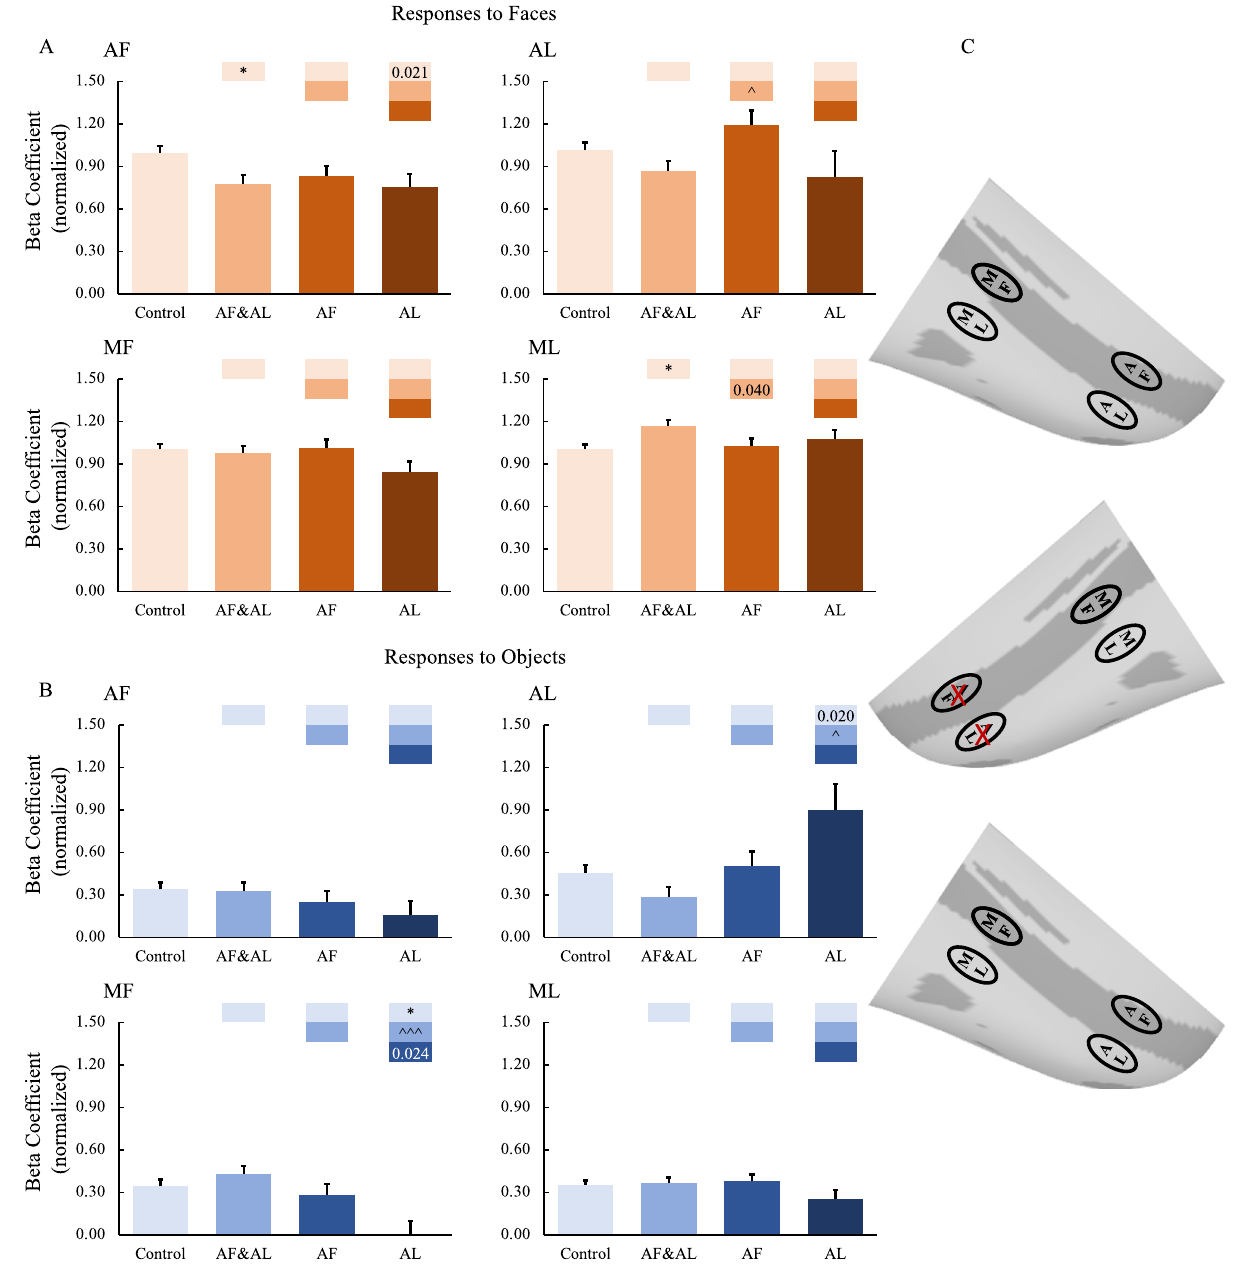
Fig. 6 | Effects of anterior face patch inactivation on responses in the con- tralateral temporal face patches. A , B Effects of anterior face patch inactivation on responses to faces and objects in the temporal face patches in the hemisphere contralateraltotheinactivationsitesacrossbothmonkeys.Boxplotsdisplaymean values±SEM. The name of the ROI is shown at the top left of each panel. AF&AL: combined AF and AL inactivation; AF: AF alone inactivation; AL: AL alone inacti- vation.GeneralizedLinearMixedModelswereperformedforeachROI(AF,MF,and ML: n =486; AL: n =336) with Treatment and Hemisphere as fi xed factors, and Monkey (C and D), L-R hemisphere (Left and Right), Session, and Run as random factors. Post hoc testing was done with correction for multiple testing using the Holm-Bonferroni method. Color bars above a particular histogram contain the